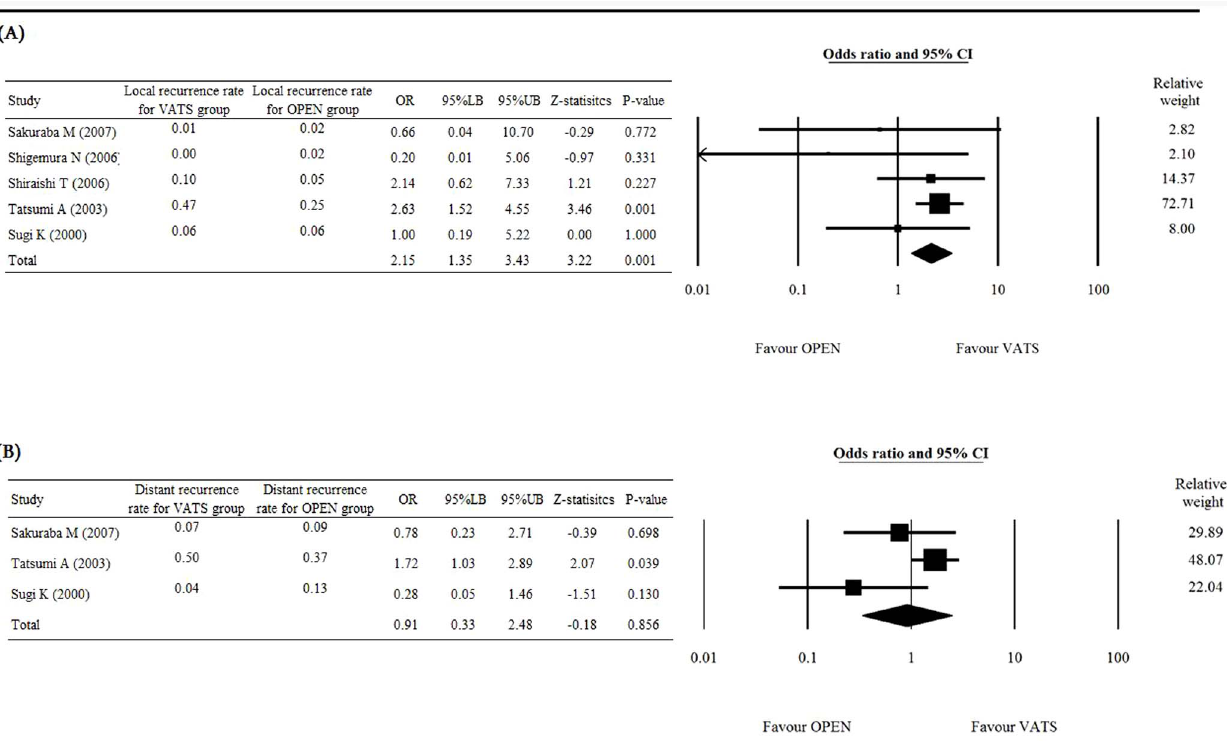
Figure 4. Forest plot for the VATS vs. open surgery groups. (A) local recurrence and (B) distant recurrence rate. OR, odd ratio; LB, lower boundary; UB, upper boundary; CI, confidence interval.